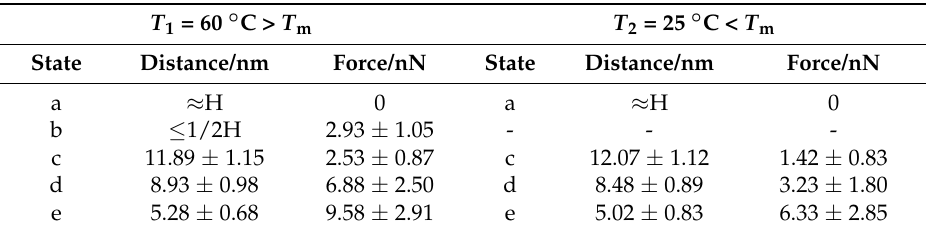
Table 1. Summary of tip-surface distance and corresponding force for the first tip approach on DPPC vesicles under two adsorbed temperatures. H is the height of the original vesicle. The statistics of the curves at T 1 and T 2 come from 20 samples (vesicles), respectively.